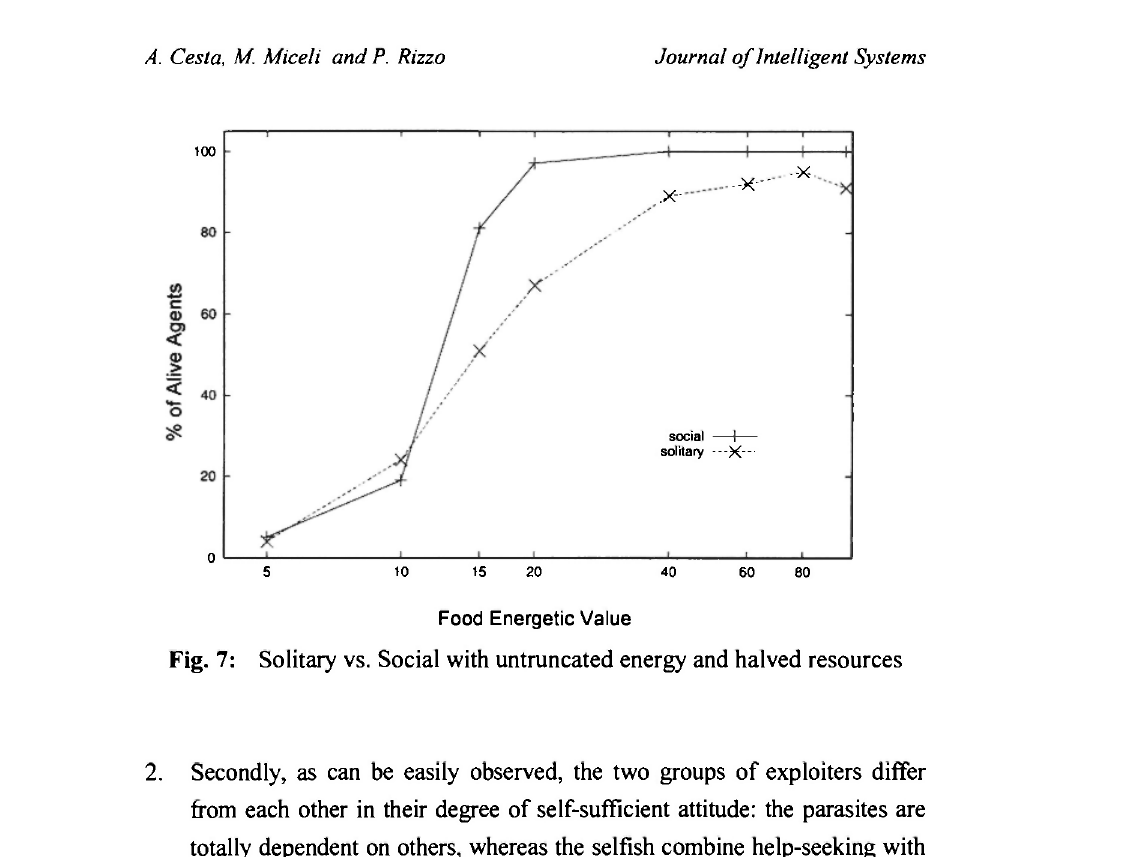
Fig. 7: Solitary vs. Social with untruncated energy and halved resources